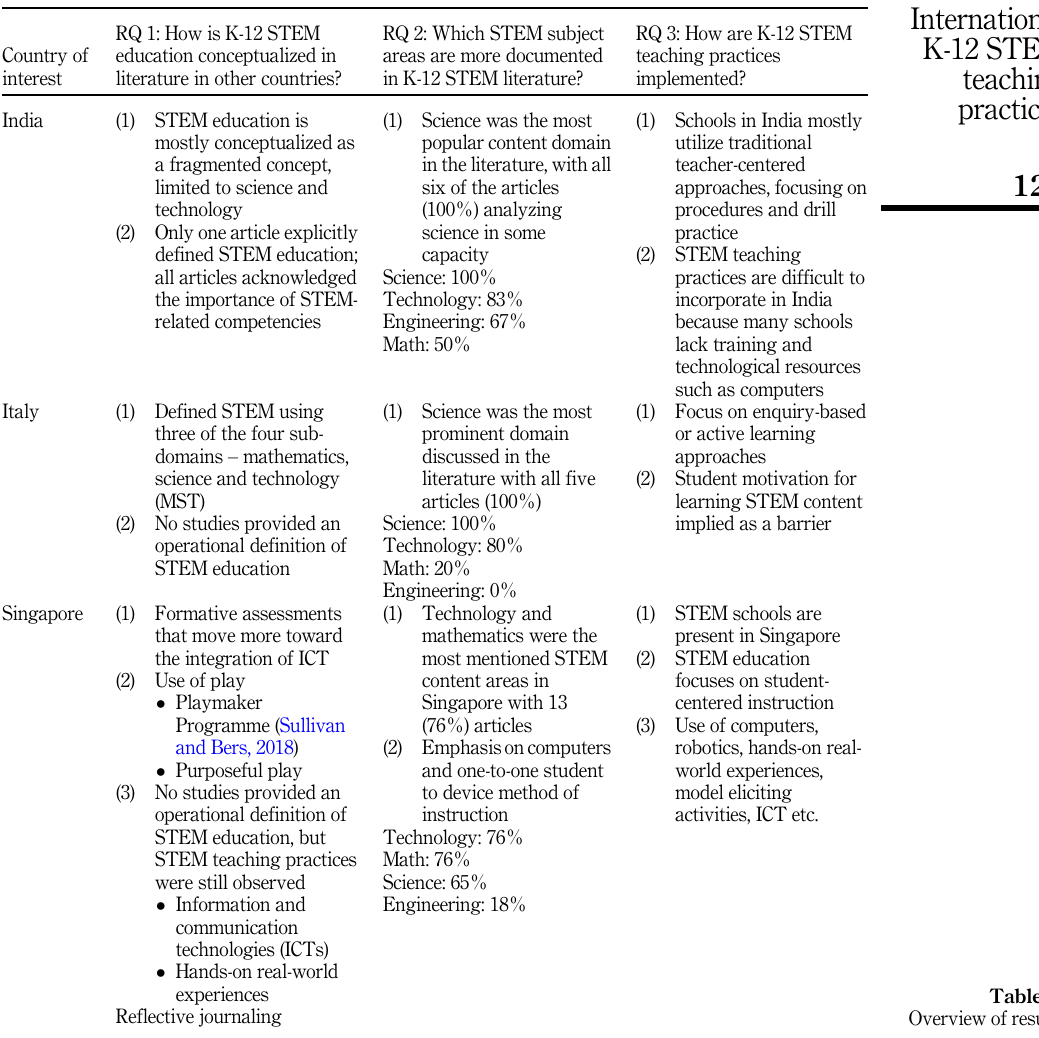
Table 3. Overview of